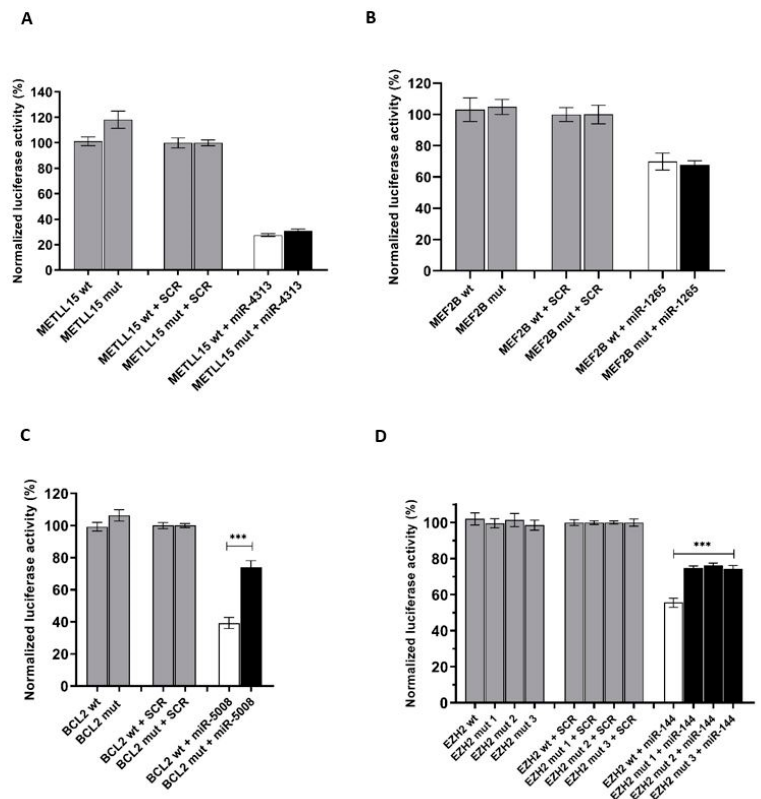
Figure 3. Luciferase results for the mutated target sequences: Luciferase data showed that the mutations identified in BCL2 ( C ) and EZH2 ( D ) genes in FL patients negatively interfere with miR-5008 and miR-144 binding, respectively, as a significant increase in the luciferase activity could be detected compared to the wildtype condition. In contrast, this was not observed in METTL15 ( A ) and MEF2B ( B ). SCR refers to a scramble miRNA sequence used as a negative control. For EZH2 , mut 1 refers to c.2115A > T, mut 2 refers to c.2114T > A, and mut 3 refers to c.2114T > C. *** p <